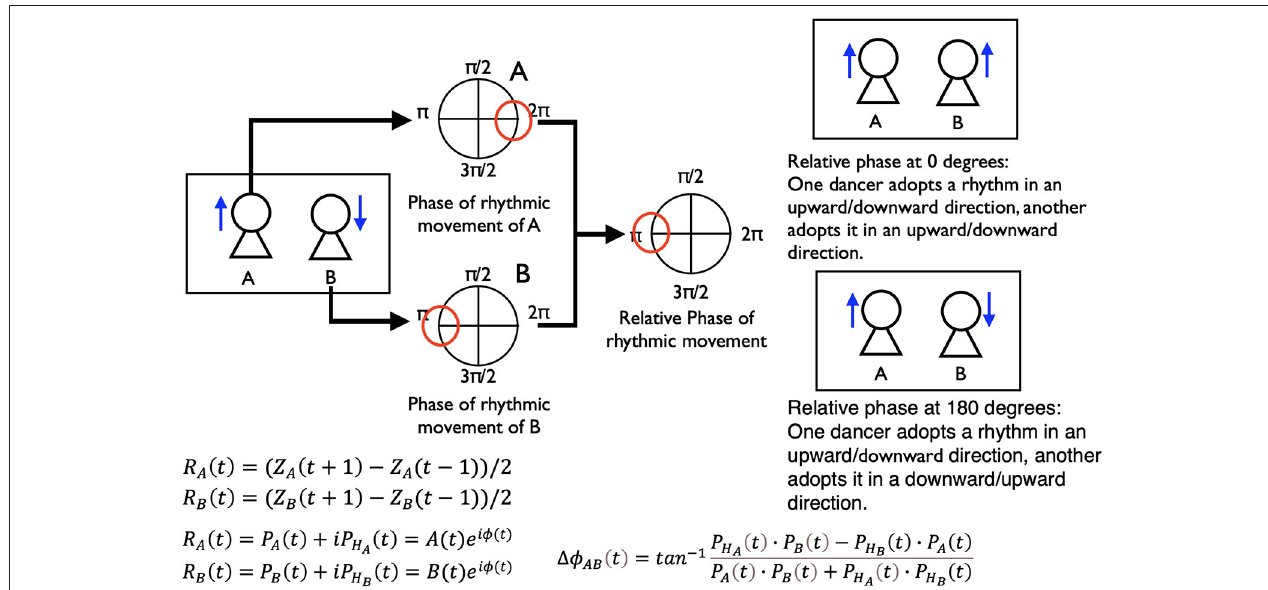
FIGURE 3 | Procedures of calculating the relative phase of the two dancers’ rhythmic movements. We made this explanation by referring to Kijima et al. (2012) and Okumura et al.